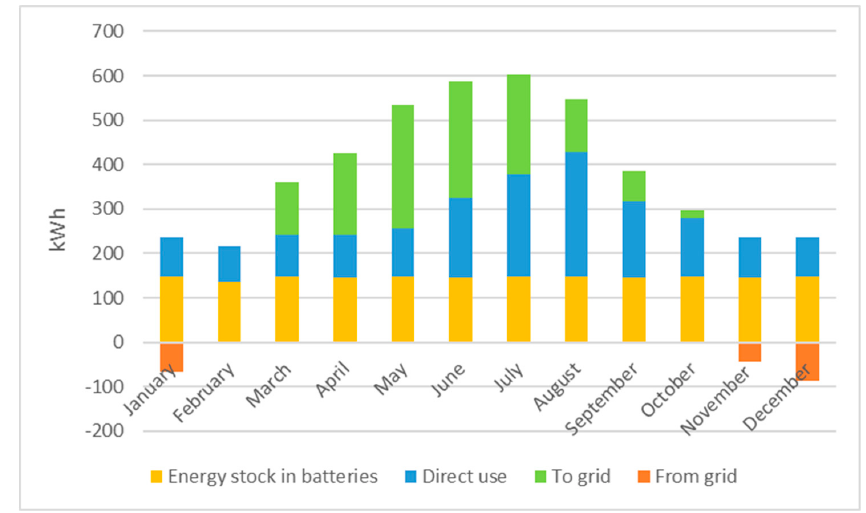
Figure 8. Monthly energy flows for the storage-on-grid PV configuration.